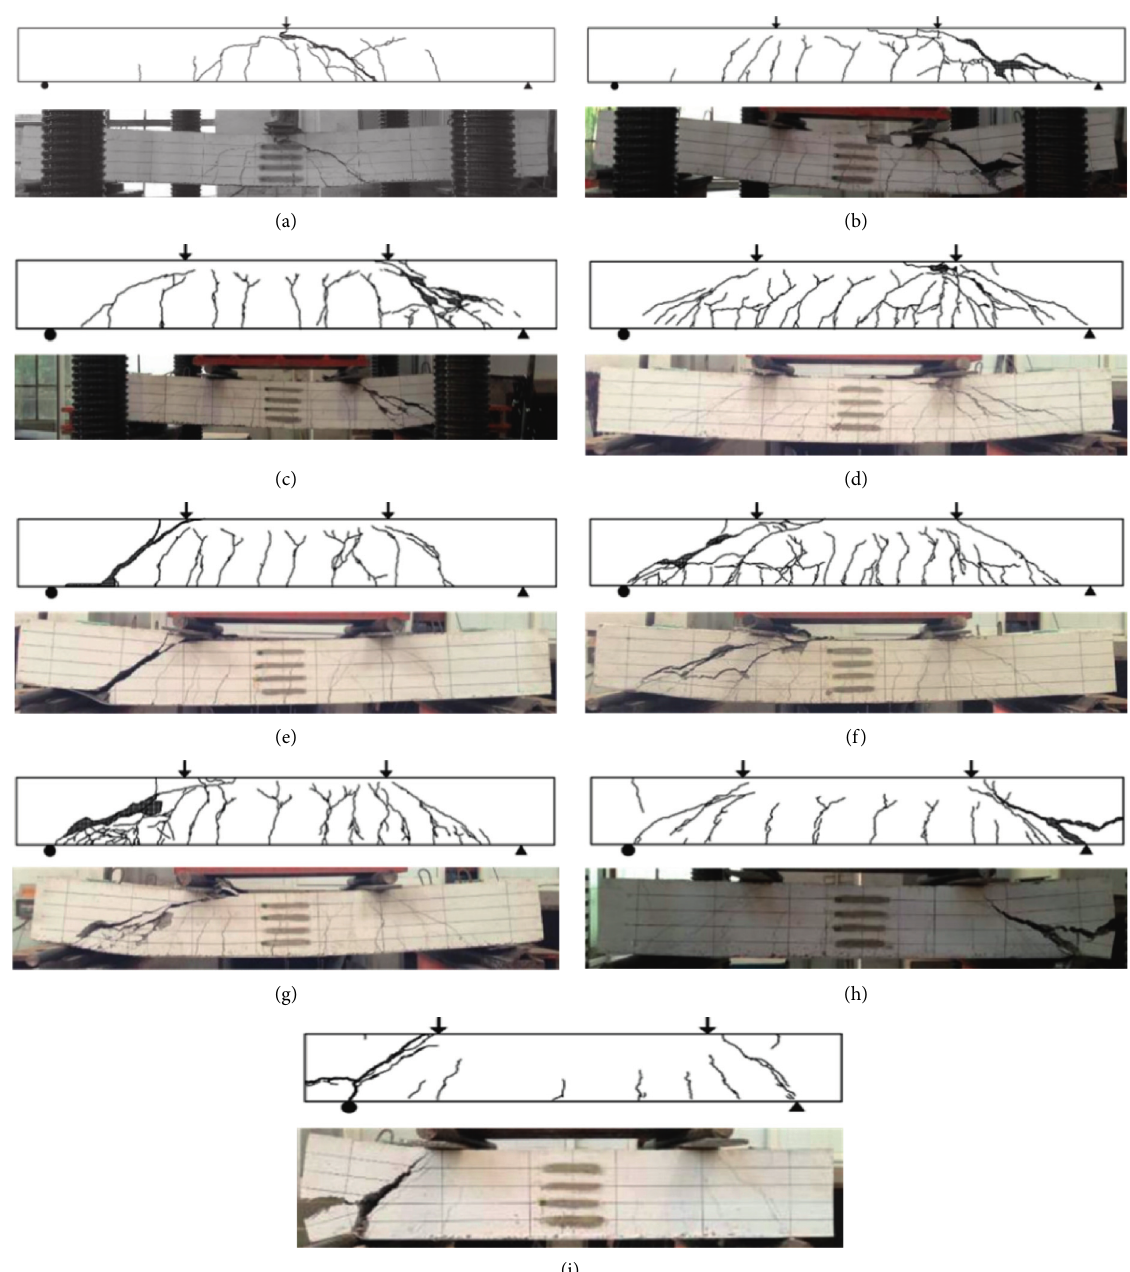
Figure 12: Deformation and crack distribution in shear failing specimens: (a) HSC2-1; (b) HSC2-2; (c) HSC2-3; (d) HSC2-4; (e) HSC2-5; (f) HSC2-6; (g) HSC2-7; (h) HSC2-9; (i)